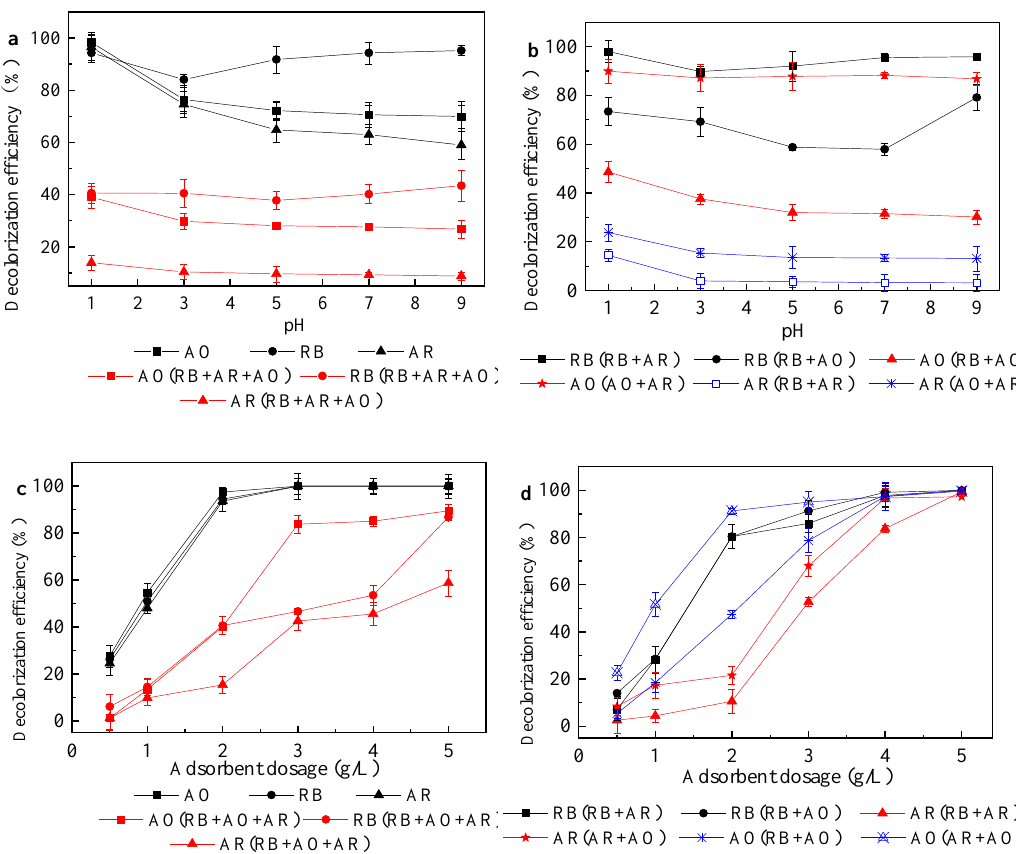
Figure 4. Effect of pH and adsorbent dosage on the Acid Orange II (AO), Reactive Blue (RB) and Acid Red (AR) adsorption performance. In ( a ) and ( b ), the adsorption test was conducted with 2 g/L modified sepiolite; In ( c ) and ( d ), the adsorption test was conducted under initial pH value of 1.